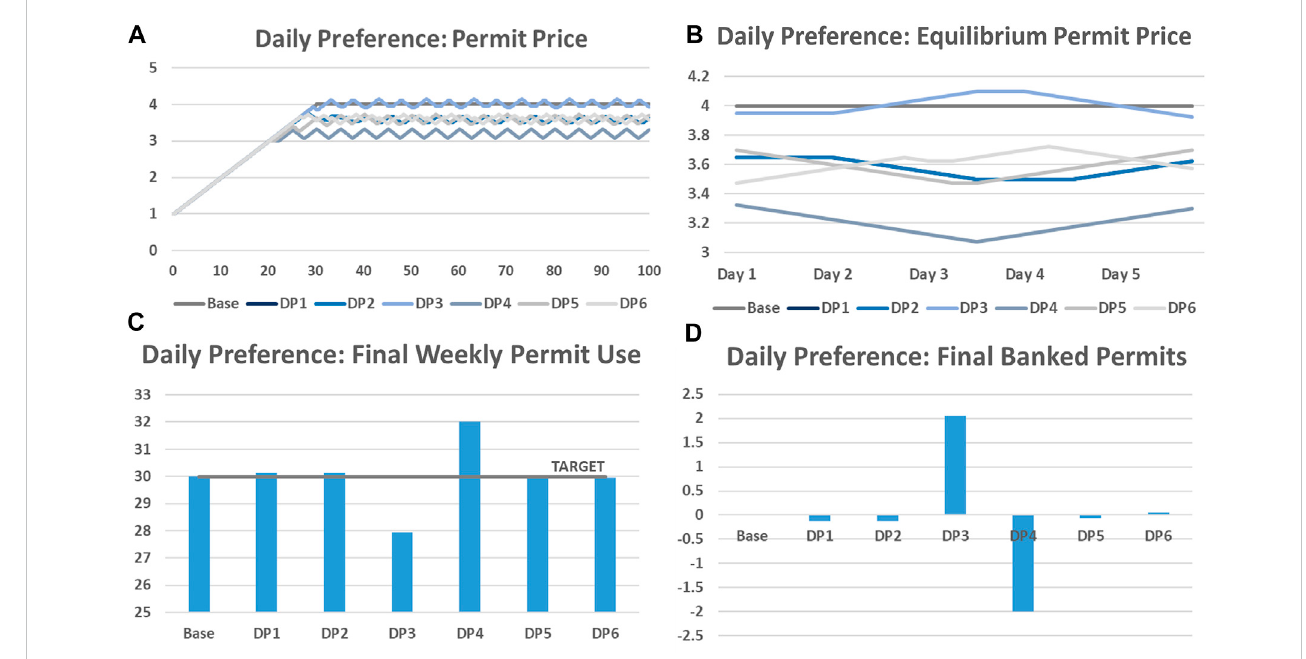
FIGURE 4 Daily Preferences: (A) : Permit price; (B) : Equilibrium permit price; (C) : Final weekly permit use; (D) Final banked